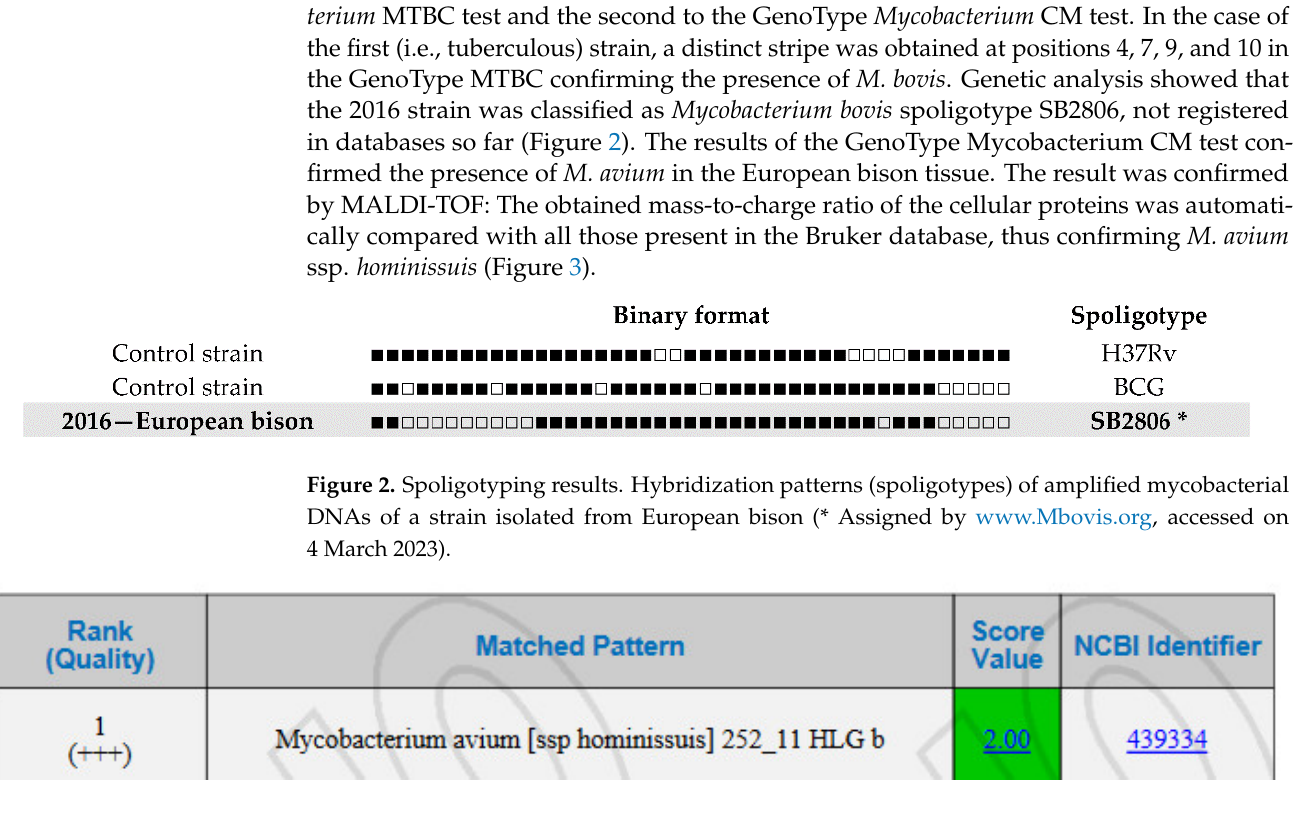
Figure 3. MALDI-TOF results. A score value ≥2.0 represents high-confidence identification.